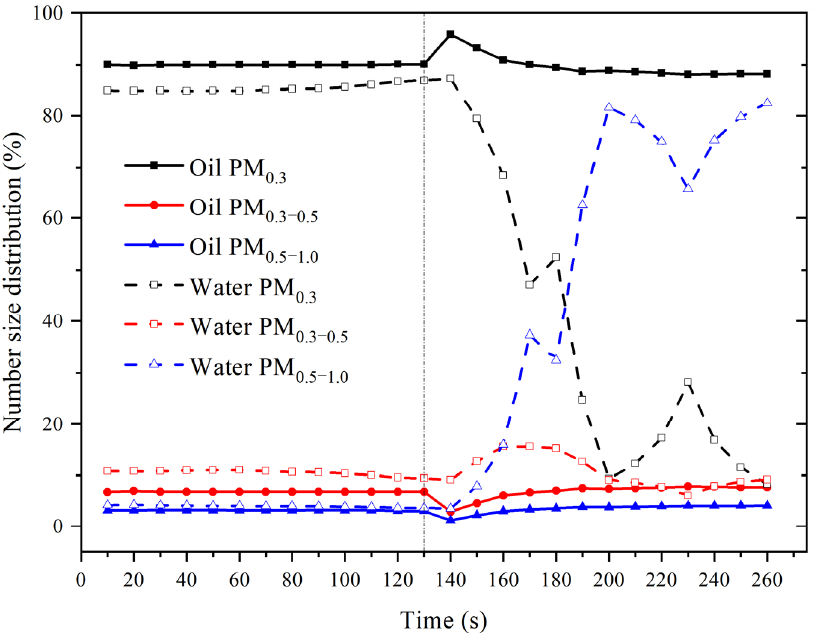
Figure 5. Comparison of changes in particle size distributions when heating water and corn oil.